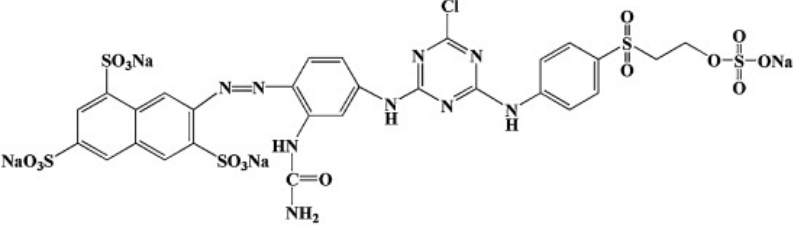
Figure 1. Chemical structure of Remazol Yellow 3RS.